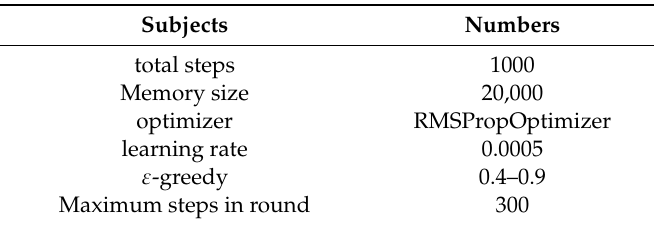
Table 2. Parameters of deep Q learning (DQN).